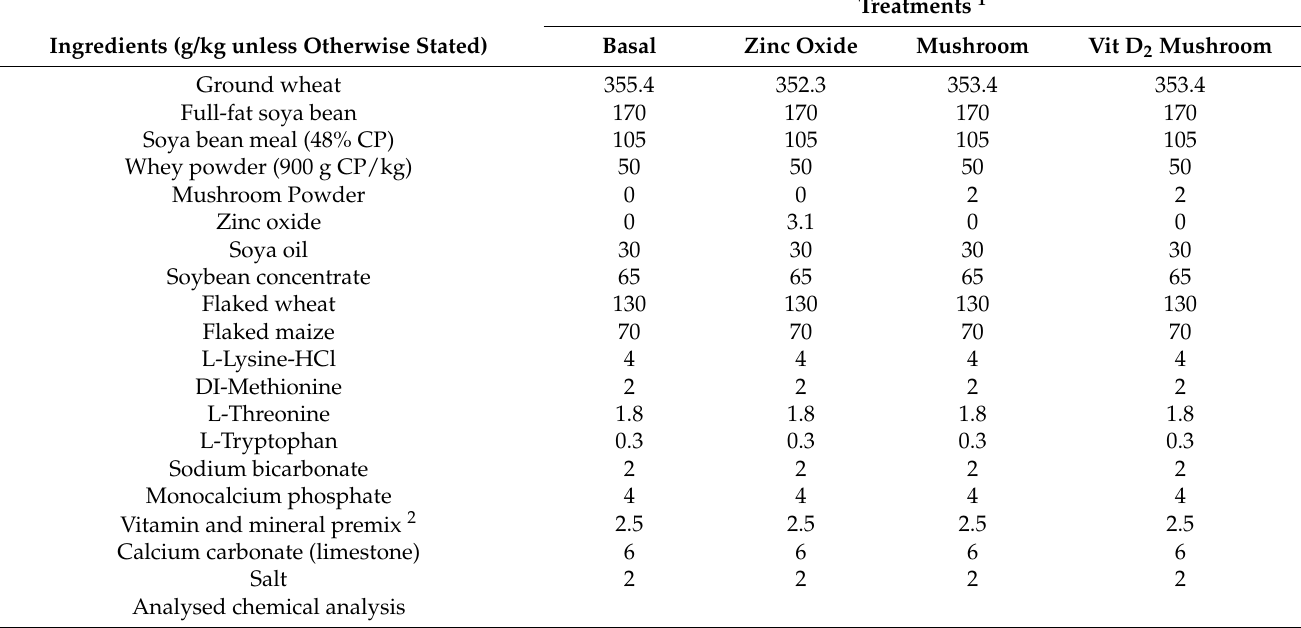
Table 1. Ingredients and chemical compositions of the